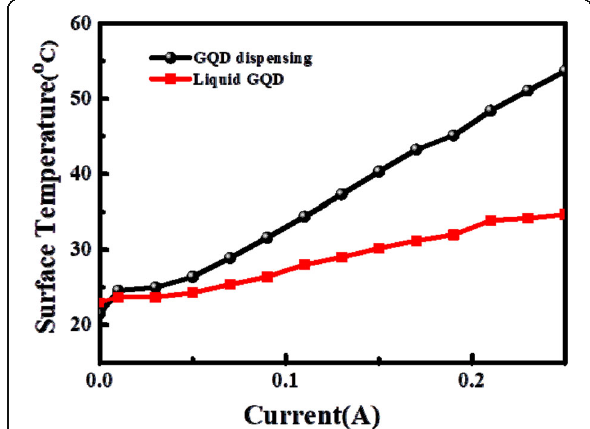
Fig. 5 Average surface temperature and current dependence of liquid-type and dispensing white